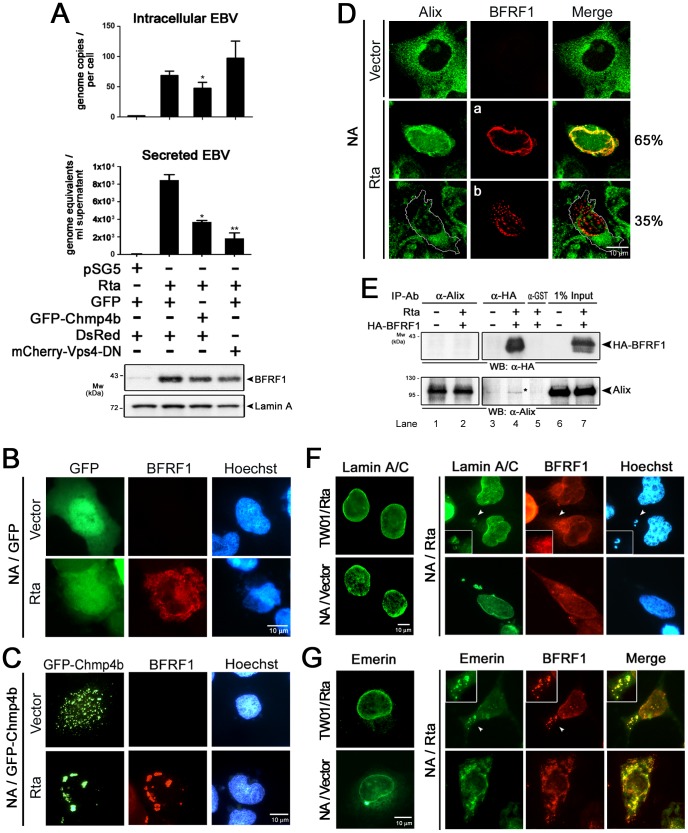
The ESCRT machinery contributes to EBV maturation and is redistributed to nucleus-associated compartments in EBV-reactivated NA cells.(A) EBV-positive NA cells were transfected with plasmids expressing GFP-Chmp4b, GFP (the GFP vector), mCherry-Vps4-DN or DsRed (the mCherry related vector) together with a plasmid expressing Rta or pSG5 vector control. The viral DNA content in the transfected cells and culture supernatant was harvested at 96 h post induction and subjected to qPCR analysis targeting the EBV DNA BamHI W fragment. Results are means ± standard deviations from two separate transfections. Data are representatives of two independent experiments. The statistically significant differences between the Rta expression alone and coexpression of Rta and GFP-Chmp4b or mCherry-Vps4-DN are calculated by the paired Student's t-test and indicated at the top of the bars. *, P<0.05; **, P<0.01. The expressed EBV BFRF1 and cellular lamin A proteins also were detected by immunoblotting using anti-BFRF1 (E10) anti-lamin A/C. Expression of GFP-Chmp4b or Vps4-DN reduced the virion secretion. (B and C) To investigate the GFP-Chmp4b localization in EBV reactivated cells, slide-cultured NA cells were transfected with plasmids expressing GFP or GFP-Chmp4b, together with Rta expressing plasmid. At 48 h post transfection, cells were fixed by 4% paraformaldehyde and immuno-stained for BFRF1 (red). Cellular DNA was detected by Hoechst 33258 staining. (D) To detect Alix protein in EBV reactivated cells, slide-cultured NA cells were transfected with Rta expressing or vector plasmid. At 48 h post transfection, cells were then fixed, stained for Alix (green) and BFRF1 (red) and observed using confocal microscopy. The cell margin in b was detected by MetaMorph software and is indicated by a white outline. Two major types of BFRF1 distribution were observed in virus- reactivated cells: a, nuclear rim distribution (∼65%) and b, nuclear rim with cytoplasmic punctate distribution (∼35%). (E) Lysates from Rta-transfected NA cells were immunoprecipitated with antibody against Alix, HA or GST antibody as a negative control. The immunocomplexes were then resolved by 10% SDS-PAGE and immunoblotted with antibodies against HA or Alix. The coimmunoprecipitated proteins are indicated by “*”. (F and G) To observe the nuclear envelope structure in EBV-reactivated cells, NA or NPC-TW01 cells were transfected with a plasmid expressing Rta to induce virus lytic replication or vector plasmid. At 72 h post transfection, cells were fixed and immuno-stained for lamin A/C (green) and BFRF1 (red), or emerin (green) and BFRF1 (red) and stained with cellular DNA. Approximately 50∼100 cells with BFRF1 expression were counted for the appearance of cytoplasmic vesicle associated lamin A/C or emerin in each set of transfection, and all the experiments were repeated independently at least twice.